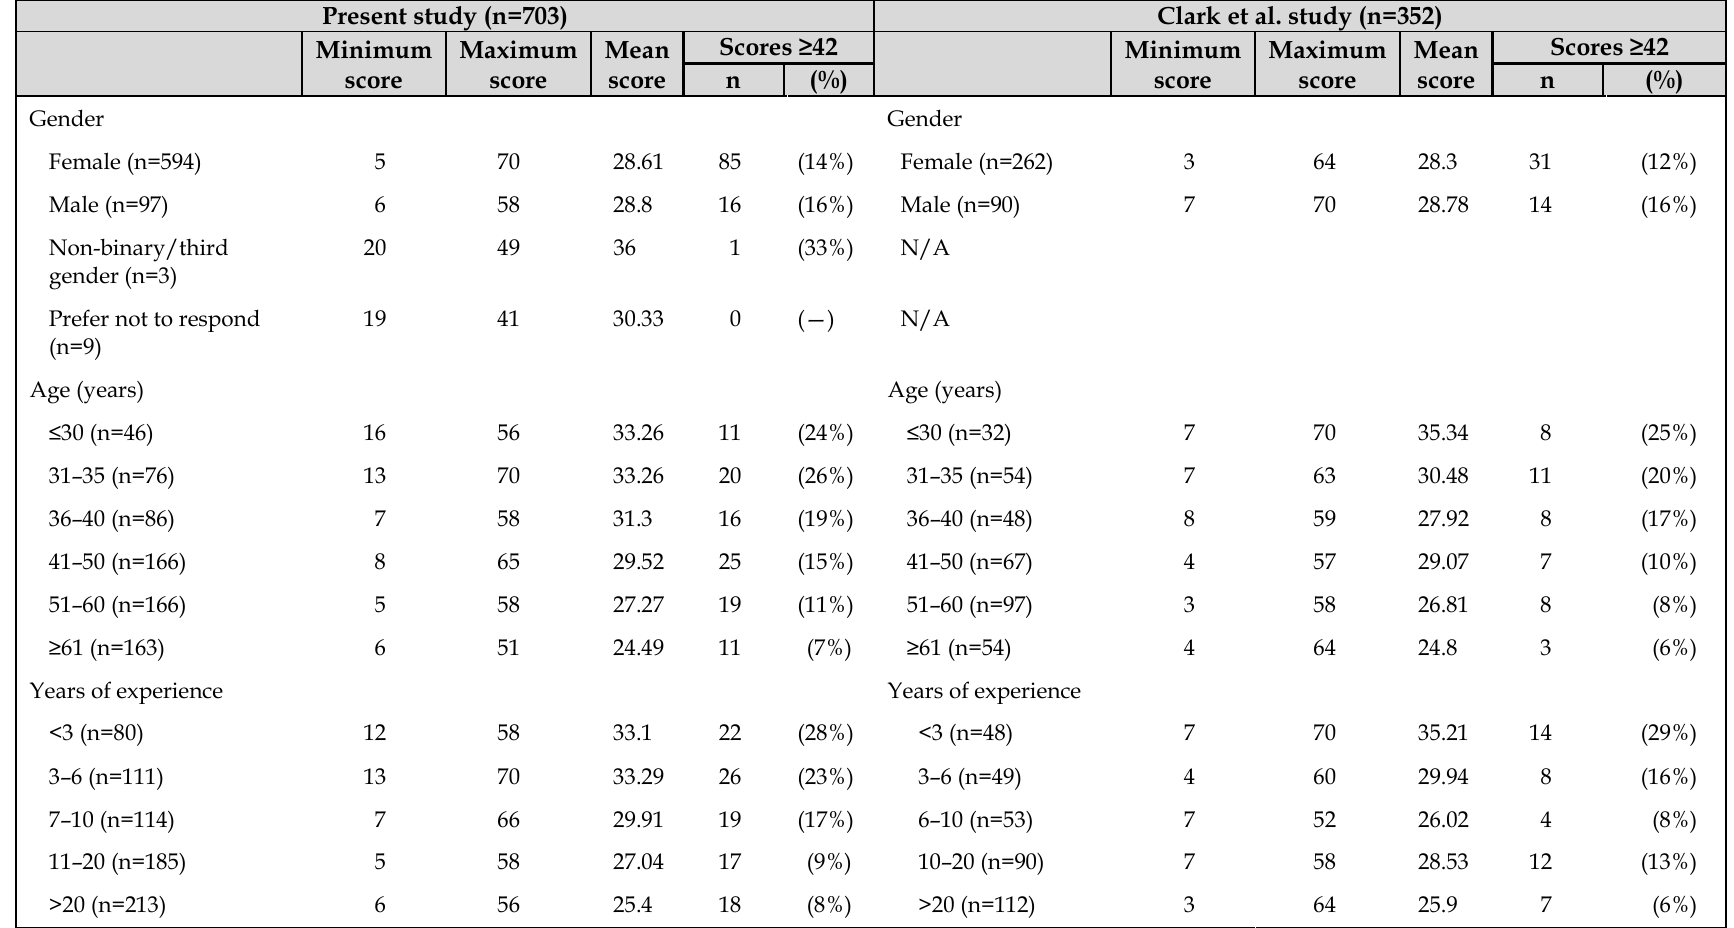
Table 1 Comparison of results between the present study and the Clark et al. 2014 study